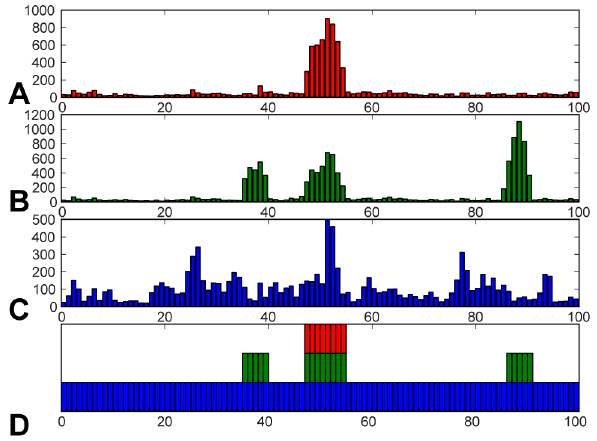
Figure 2. Plots of total angular change for each residue over the determined transition. (A) Central hinge only. (B) Hinge + flex region. (C) Automatic. (D) shows active residues explicitly used in planning for hinge (red), hinge + flex (green) and automatic (blue) runs.